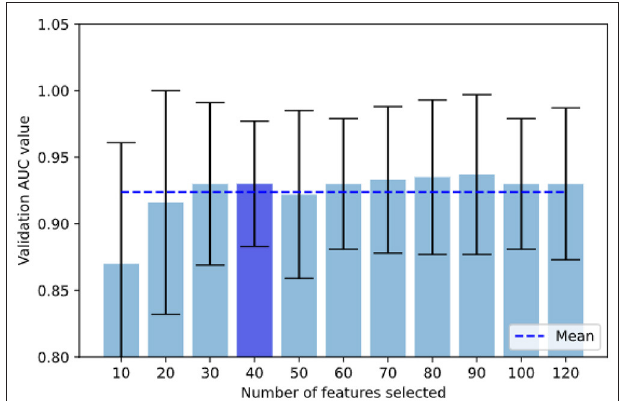
Frontiers in Cardiovascular Medicine |